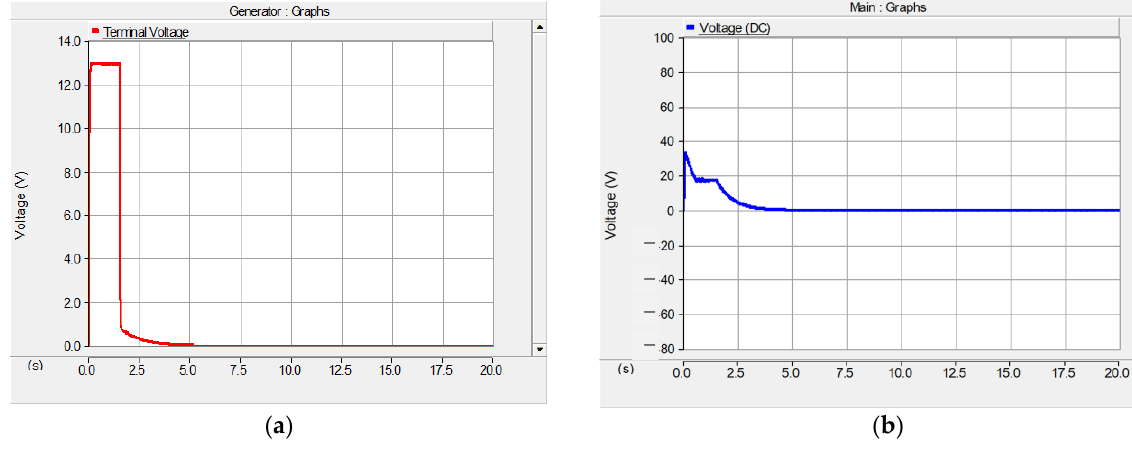
Figure 31. ( a ) Terminal voltage; ( b ) DC voltage.